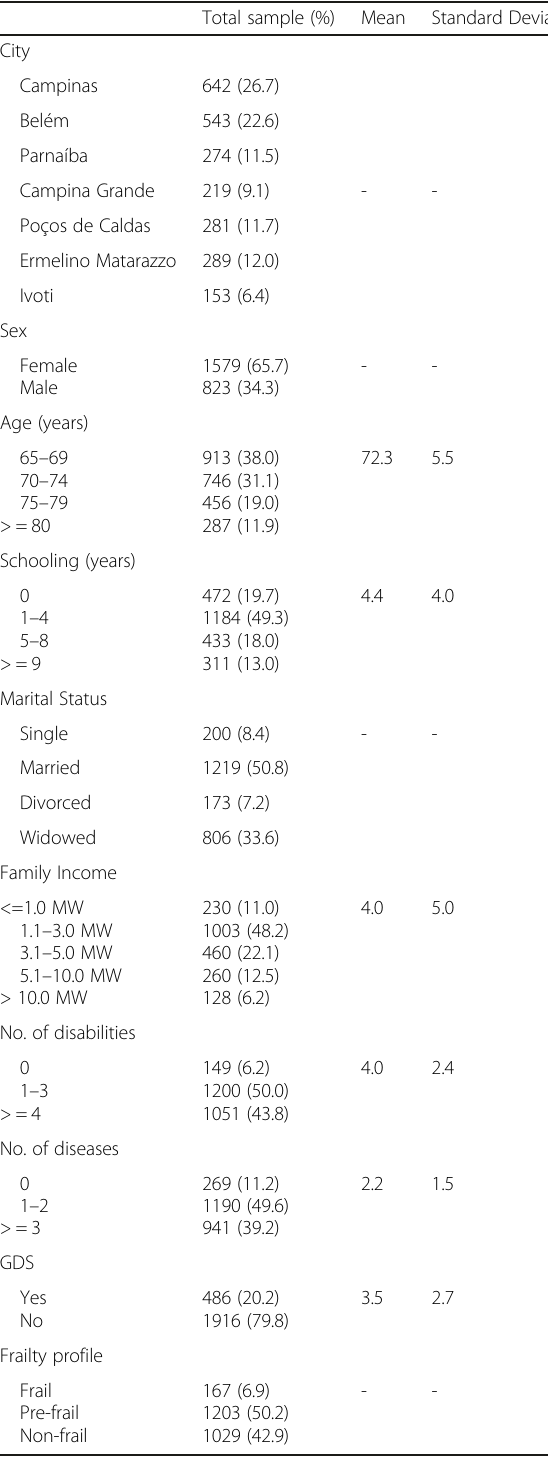
Table 1 Sample description according to sociodemographic variables, number of disabilities and self-reported diseases, GDS and frailty profiles ( n = 2402). FIBRA Unicamp, Elderly, 2008 –